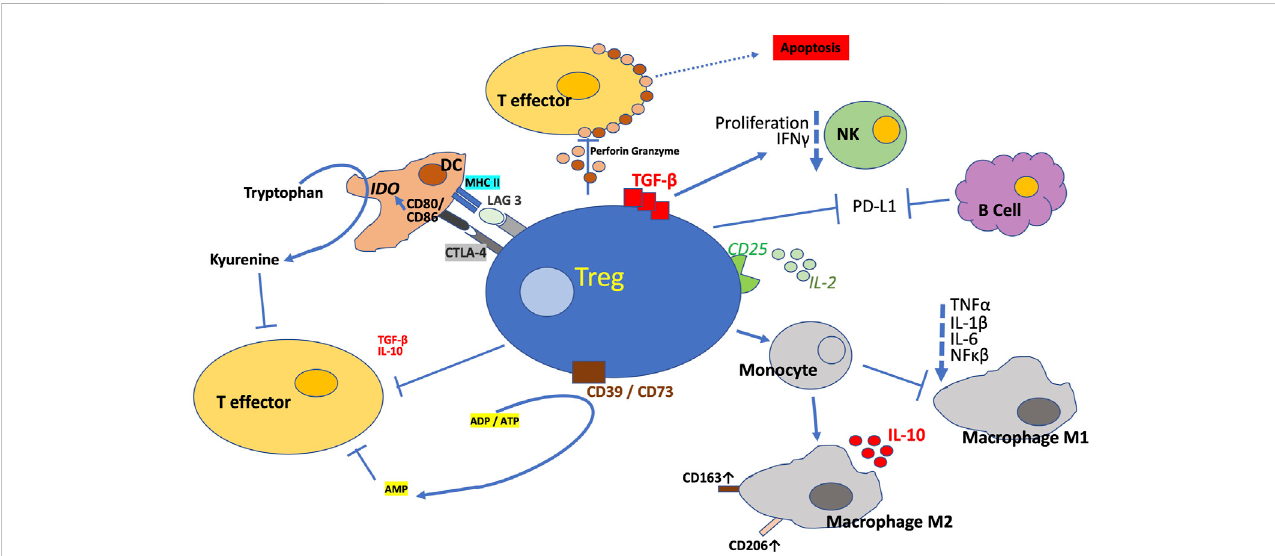
FIGURE 1 MechanismsofSuppression.Tregssuppressinnateandadaptiveimmuneresponses via